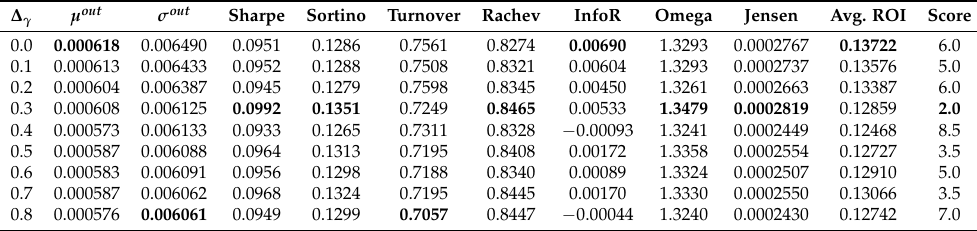
Table 8. EuroBonds: out-of-sample performance results for the KP R strategy by varying ∆ γ .